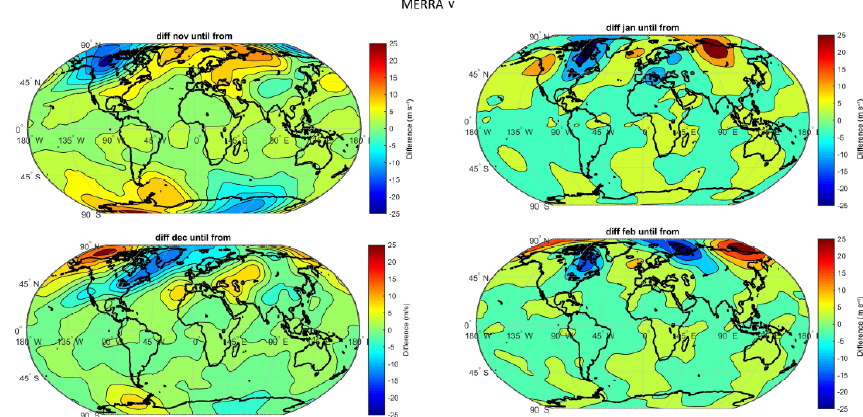
Figure 11. The difference between two periods (1979–1997 and 1998–2015) of meridional wind trends for 2 different months (difference between the first period and the second one: November – left upper panel, December – left bottom panel, January – right upper panel, February – right bottom panel) from the MERRA reanalysis at